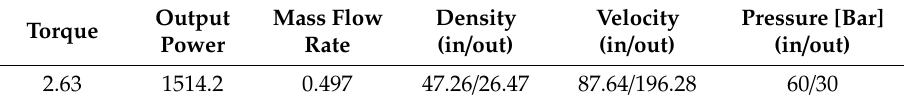
Table 8. Results of a numerical experiment for specified TT (parameters are in the SI unit). Torque